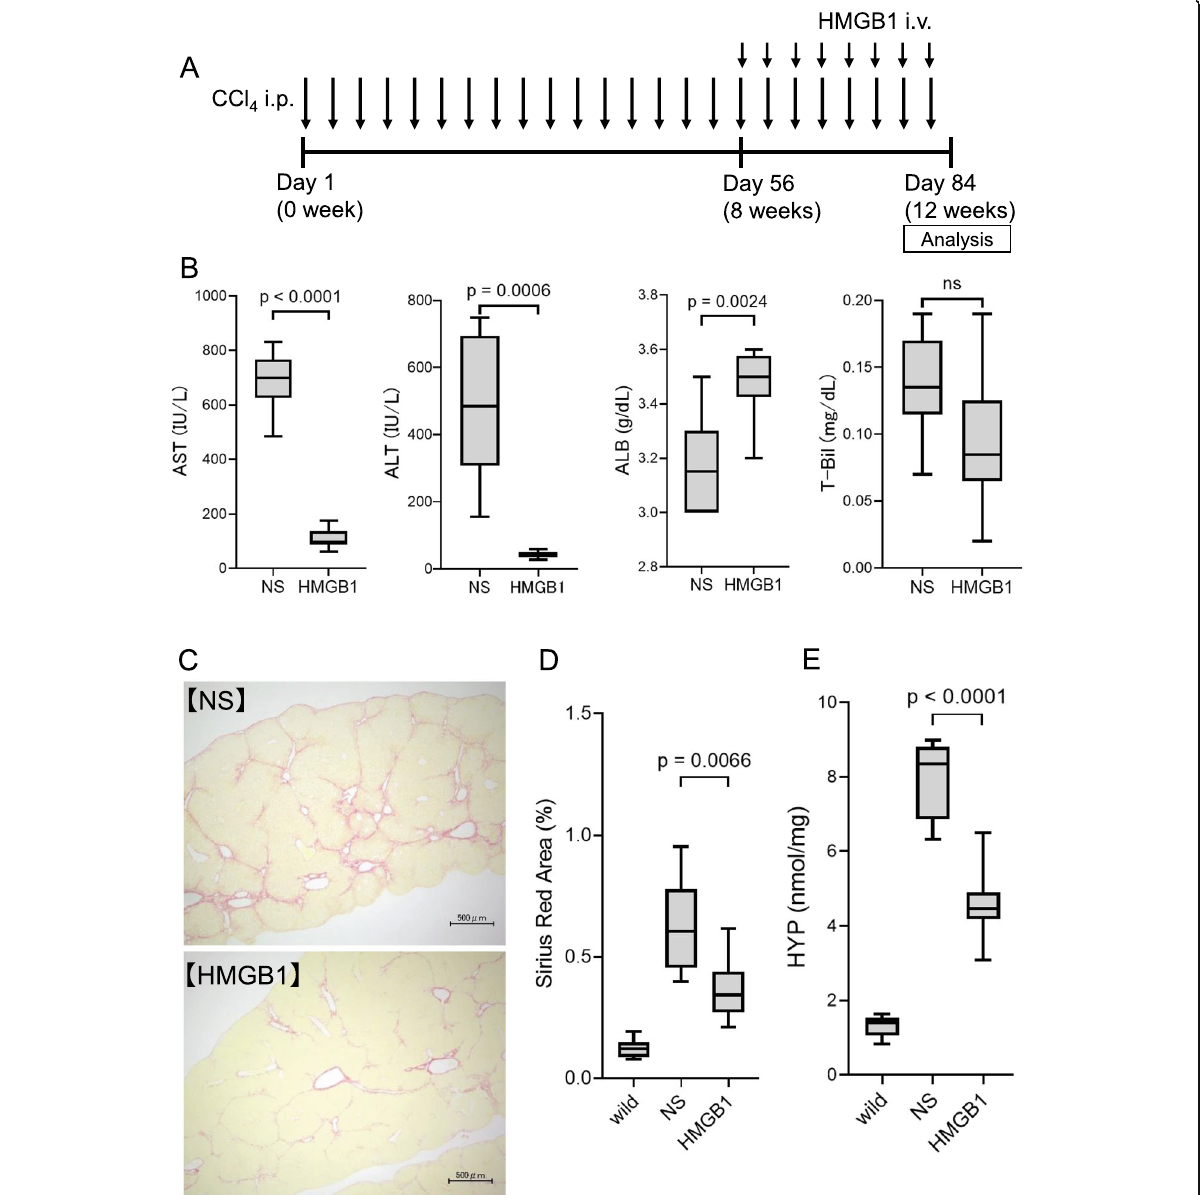
Fig. 1 Therapeutic effects of HMGB1 peptide (4 weeks of treatment) in the CCl 4 -induced mouse cirrhosis model. A Schematic of this experiment. B Serum levels of aspartate transaminase (AST), alanine transaminase (ALT), albumin (ALB), and total bilirubin (T-Bil). C Sirius Red staining of liver tissues. Scale bar = 500 μ m. D The frequency of Sirius Red staining. E Quantification of hydroxyproline (HYP). NS, normal saline, n = 8 in each group. Data are presented as means ± standard deviations. ns, not significant. wild, basic data of from undamaged normal liver at the same